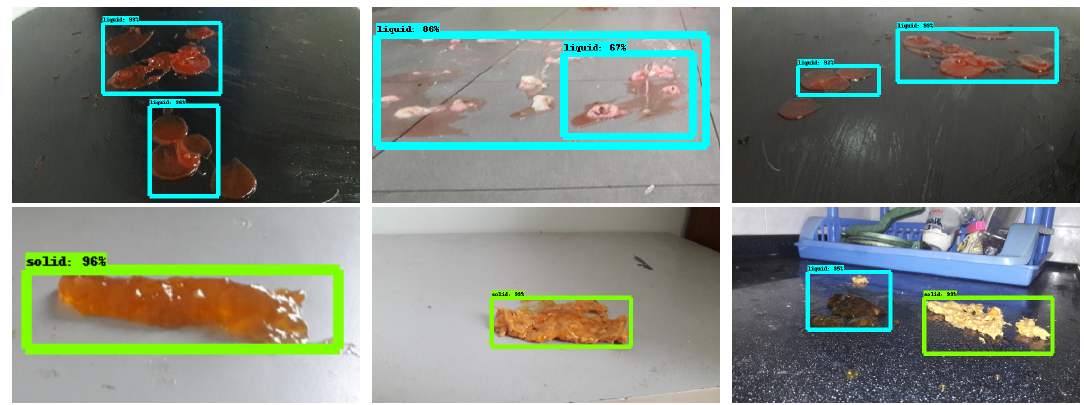
Figure 5. Front View Results.